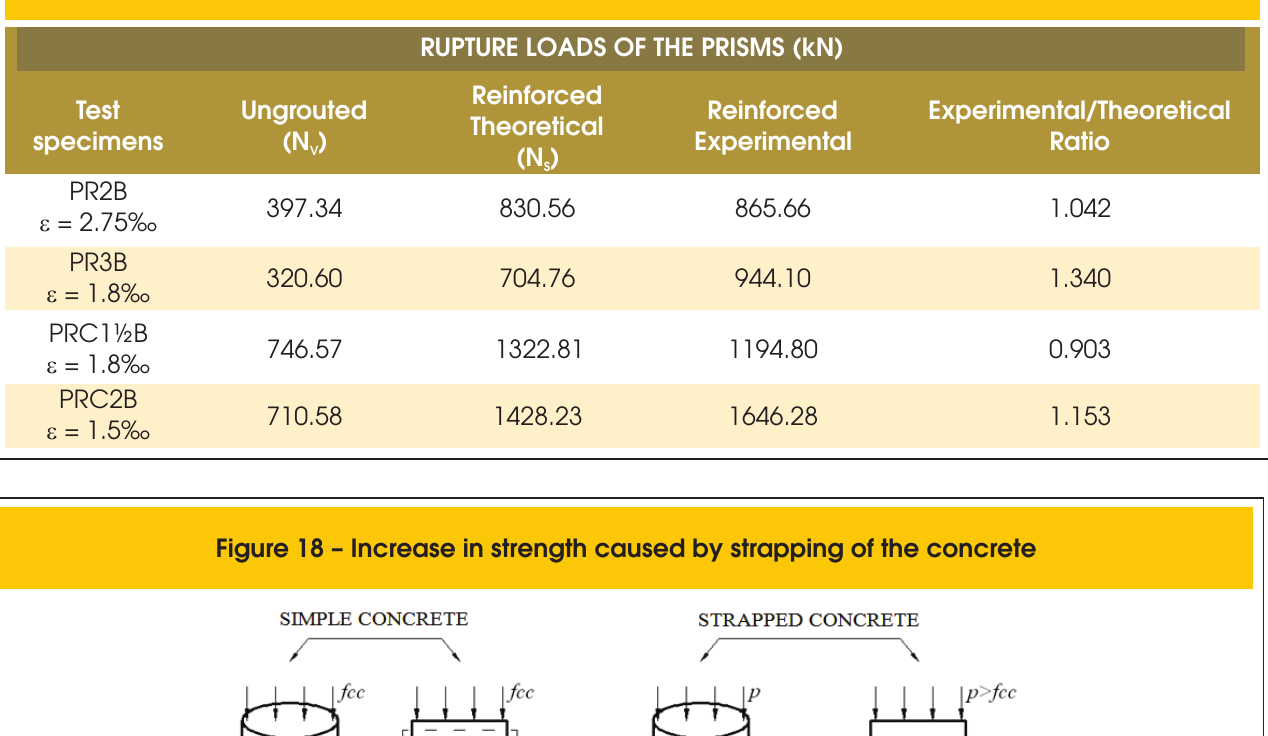
Table 8 – Comparison of mean theoretical and experimental loads for break strain (Model